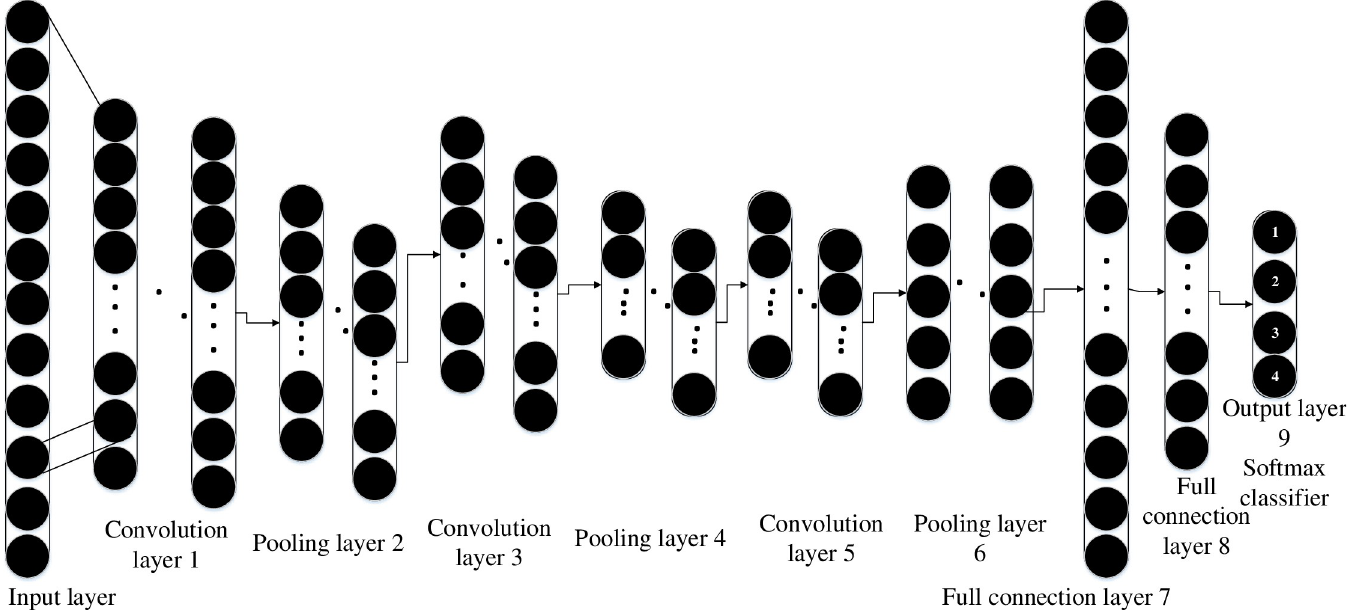
Fig 3. Structure for CNN based on fault diagnosis and classification of the bearing-rotor system.